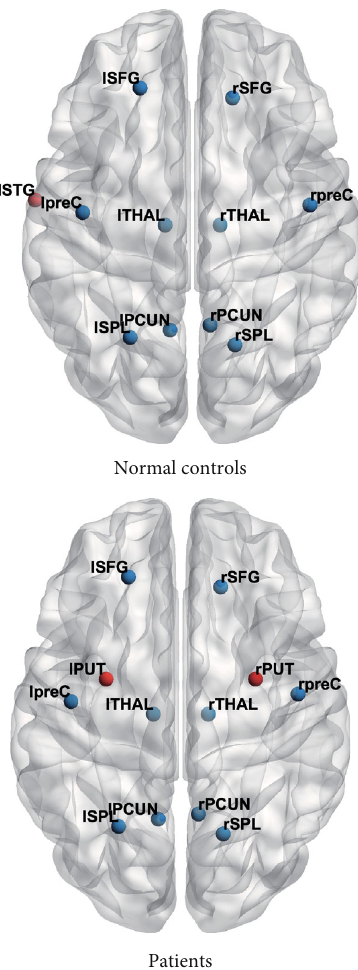
Figure 4: Hub region distribution in patients and normal controls. The nodes color-coded in blue were shared by the two groups, while the nodes color-coded in red were not. Table 3: Hub regions of normal controls and patients. Normal